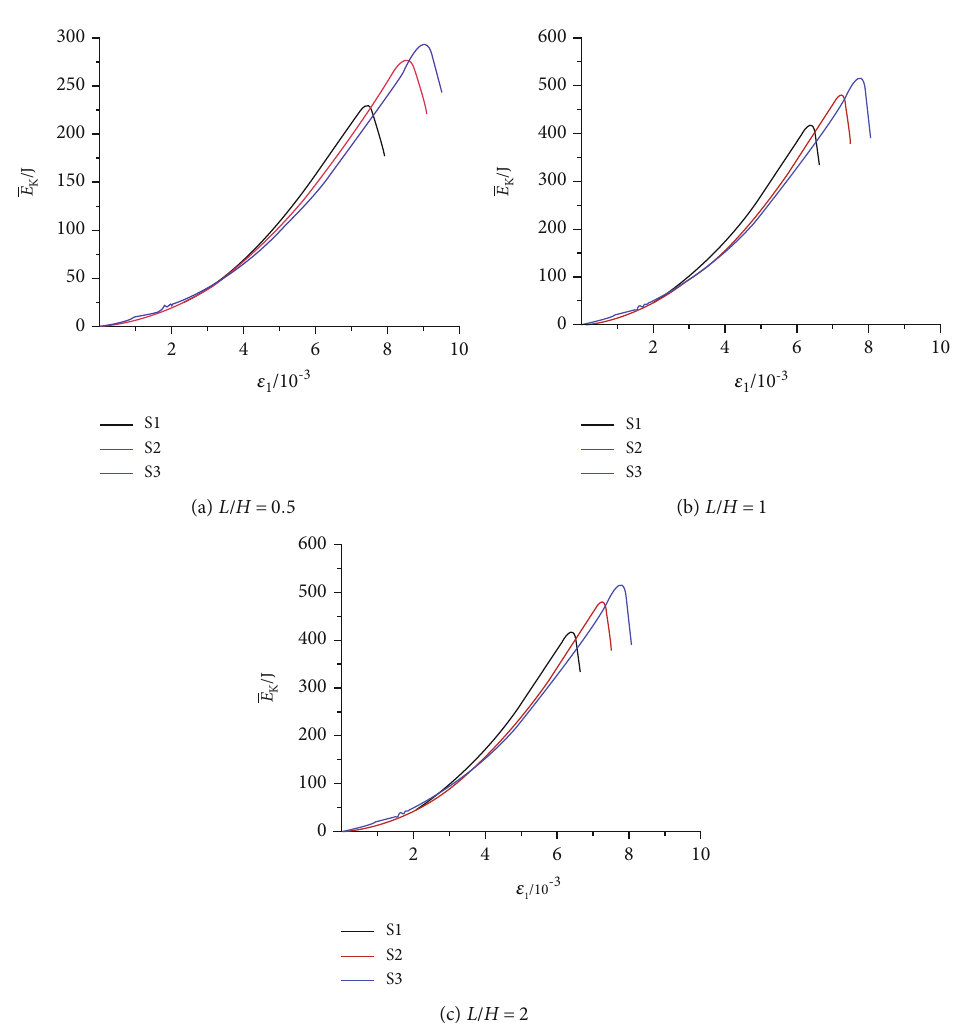
Figure 6: Curves of the strain energy